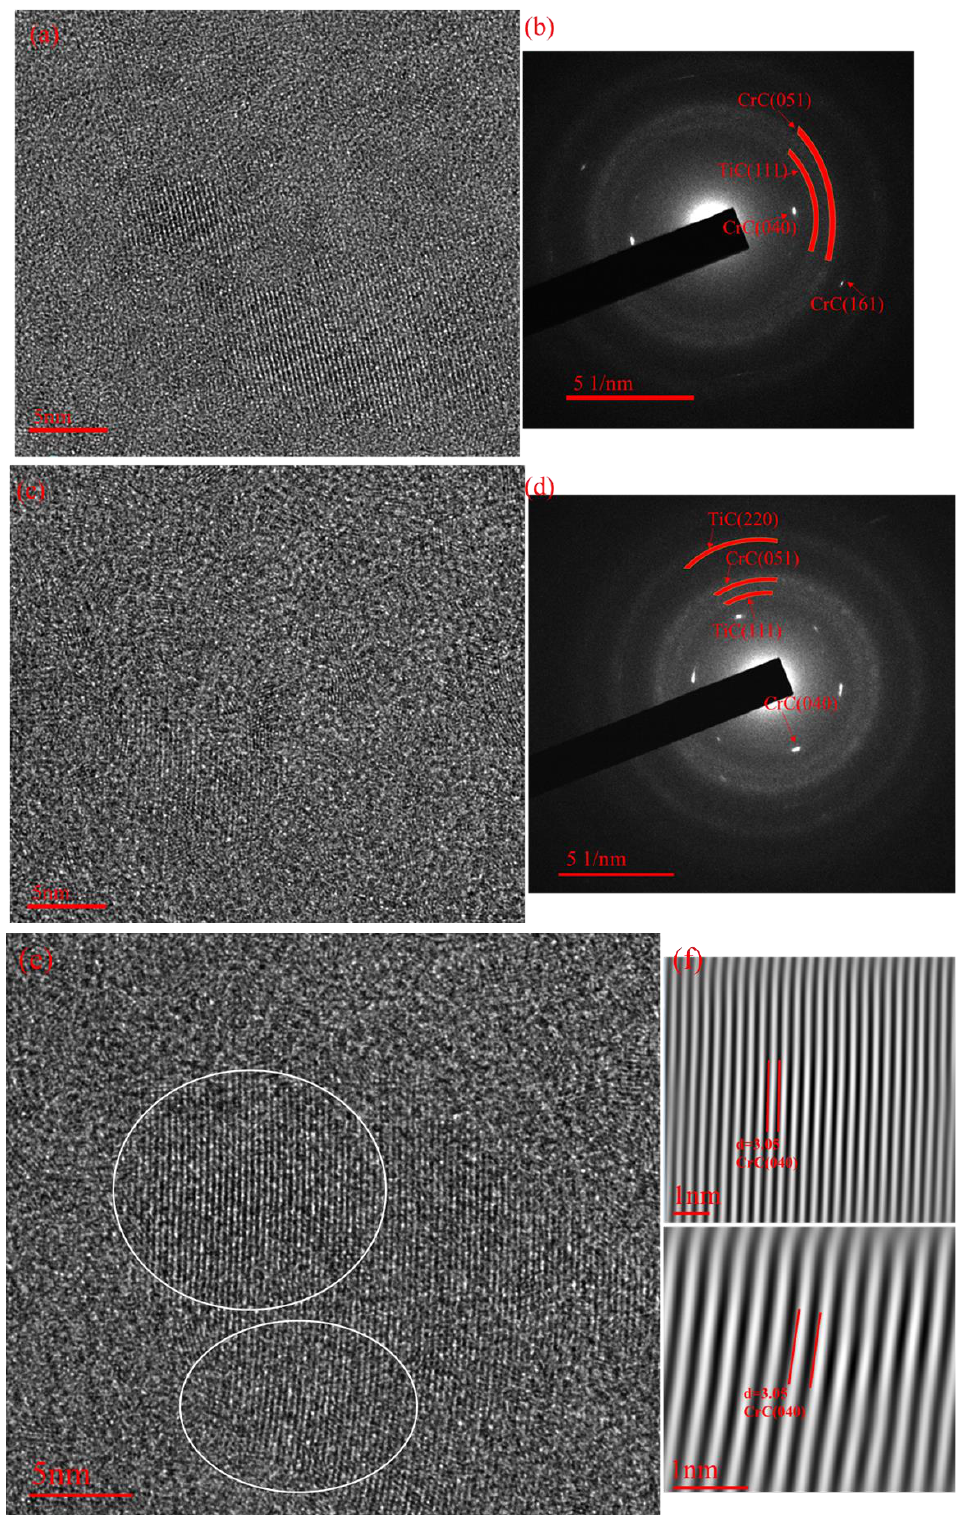
Figure 5. TEM images and inset SAED patterns of the Ti, Cr co-doped amorphous carbon film: ( a , b ) Ti-1, ( c , d ) Ti-2, ( e , f ) Ti-0.